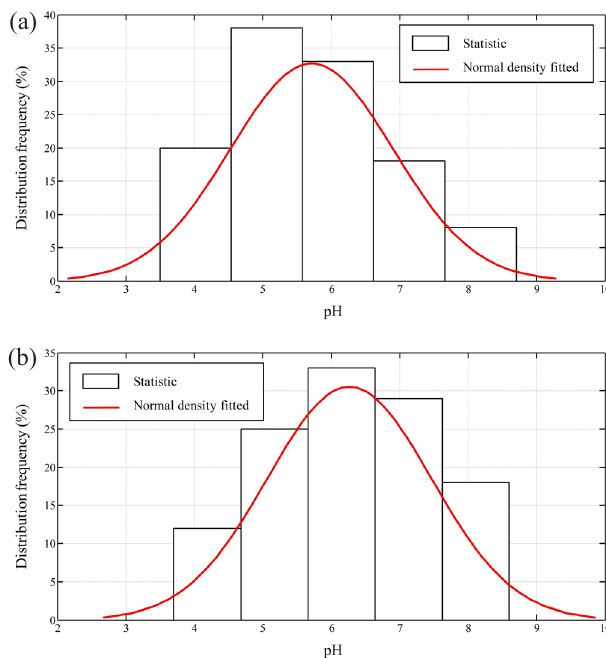
Fig 2. pH frequency distributions of surrounding soils and termite mounds. (a) Surrounding soils; (b) Termite mounds.